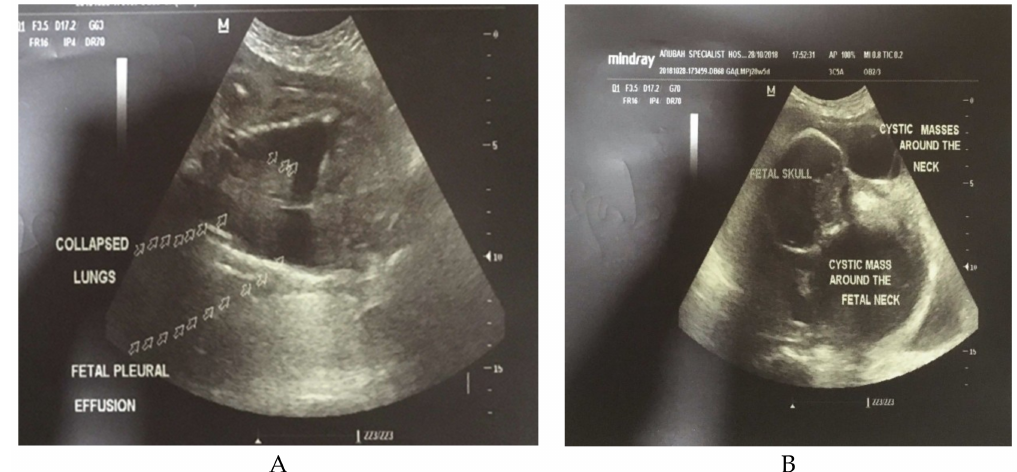
Figure 2. Ultrasound features of fetal hydrops ( A ) and Cystic hygroma ( B ).